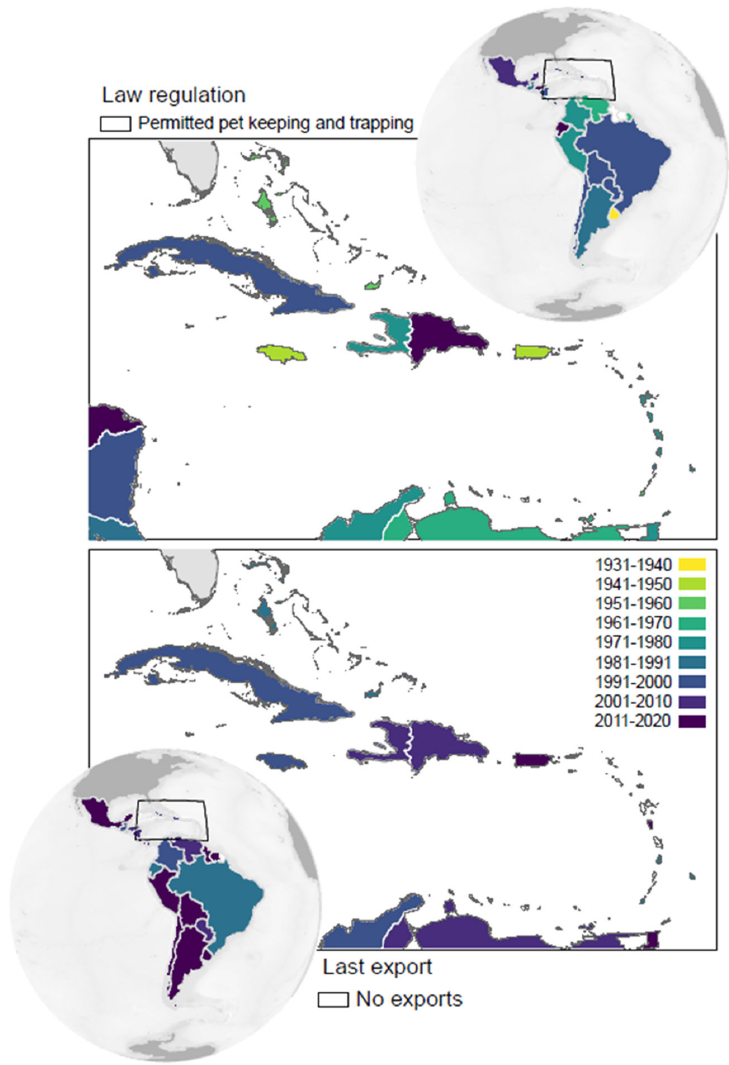
Figure 1. Years (grouped into decades) in which each country prohibited trapping of wild parrots for the domestic demand for pets ( top maps ) and in which decade countries performed the last export of wild ‐ caught parrots for the international pet markets ( bottom maps ).